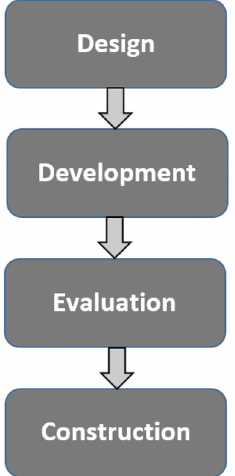
Figure 2. Questionnaire Development